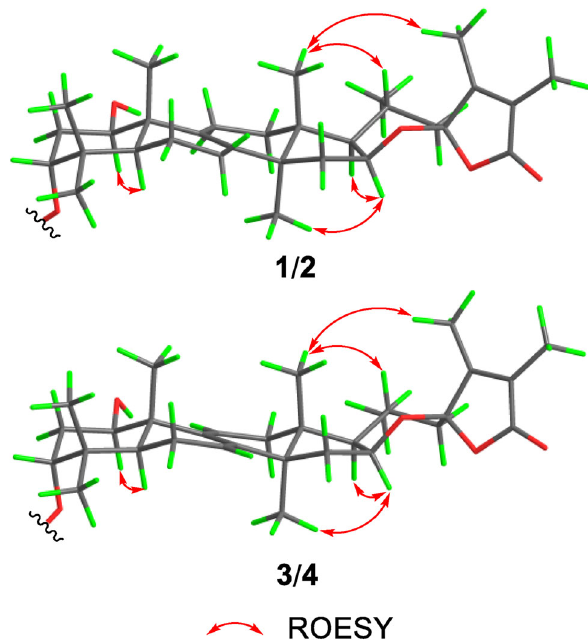
Fig. 3 Key ROESY correlations for compounds 1 – 4